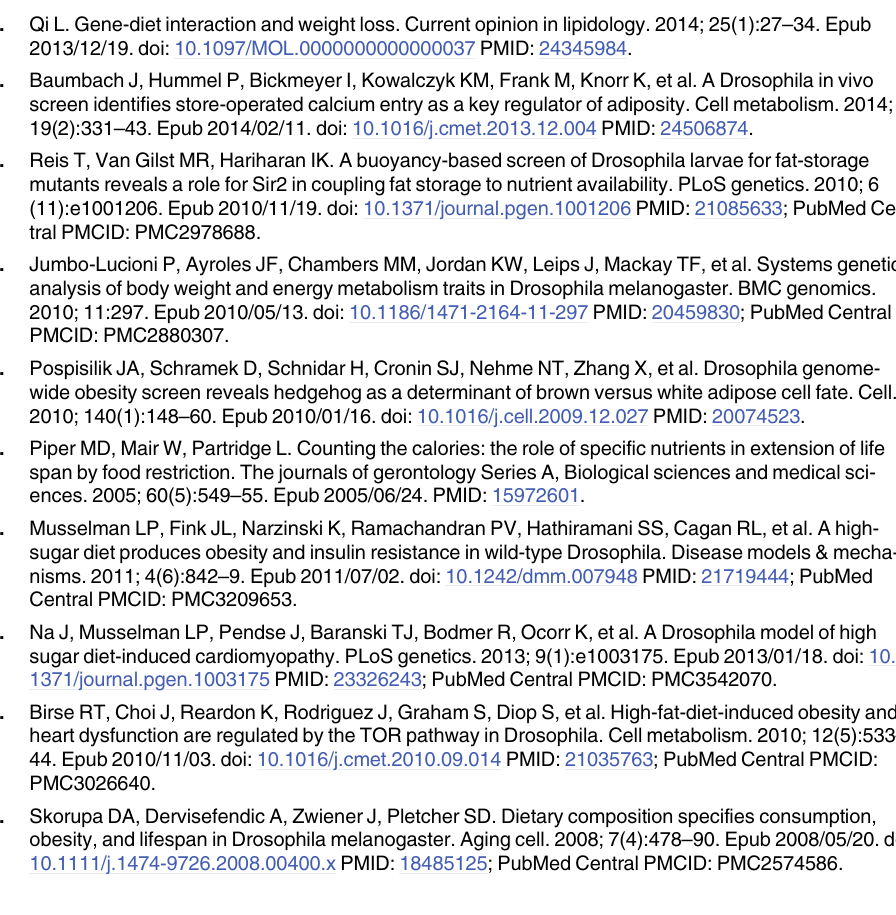
S1 Fig. Effect of enriched diets on egg laying. Eggs laid per 20 females over a 4-hr interval. For each diet, data represent three independent egg collections each from two independent populations of adults (8 – 10 days old). Asterisks indicate significant differences (P < 0.05). Error bars, standard error of the mean. Since in the variances appeared unequal, both a non- parametric test (Mann Whitney) and a t test with Welch ’ s correction for unequal variances were applied to these data. The Mann Whitney test indicated a significant increase in egg laying on the 4L diet (P = 0.0247). All other P <